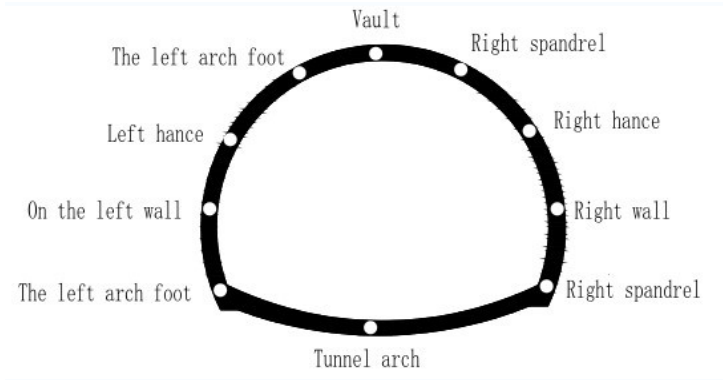
Figure 3. Layout of monitoring points on the left line.